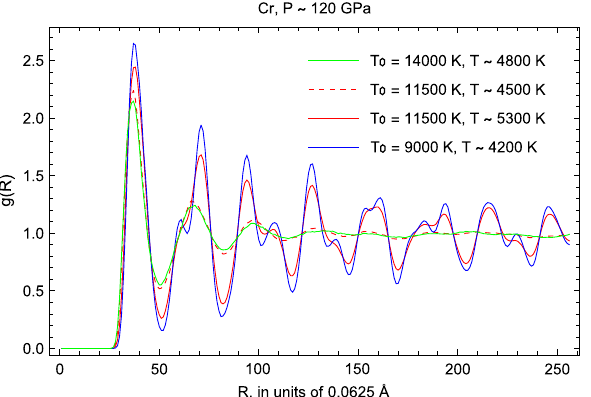
Figure 5. Radial distribution functions (RDFs) of equilibrium states of Cr in QMD Z-method runs at P GPa. The corresponding initial and equilibrium temperatures are indicated as T 0 and T ,